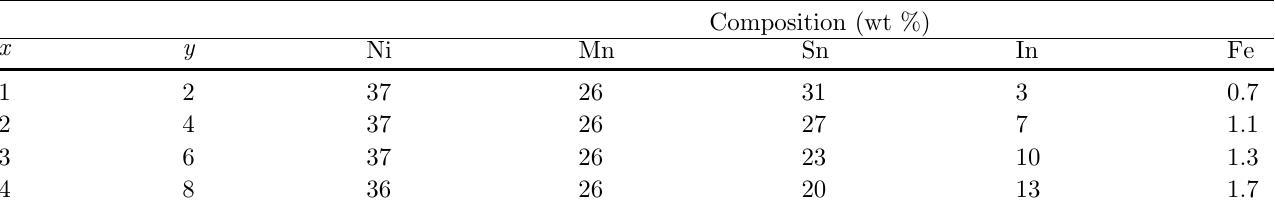
The values are accurate within±0.1%